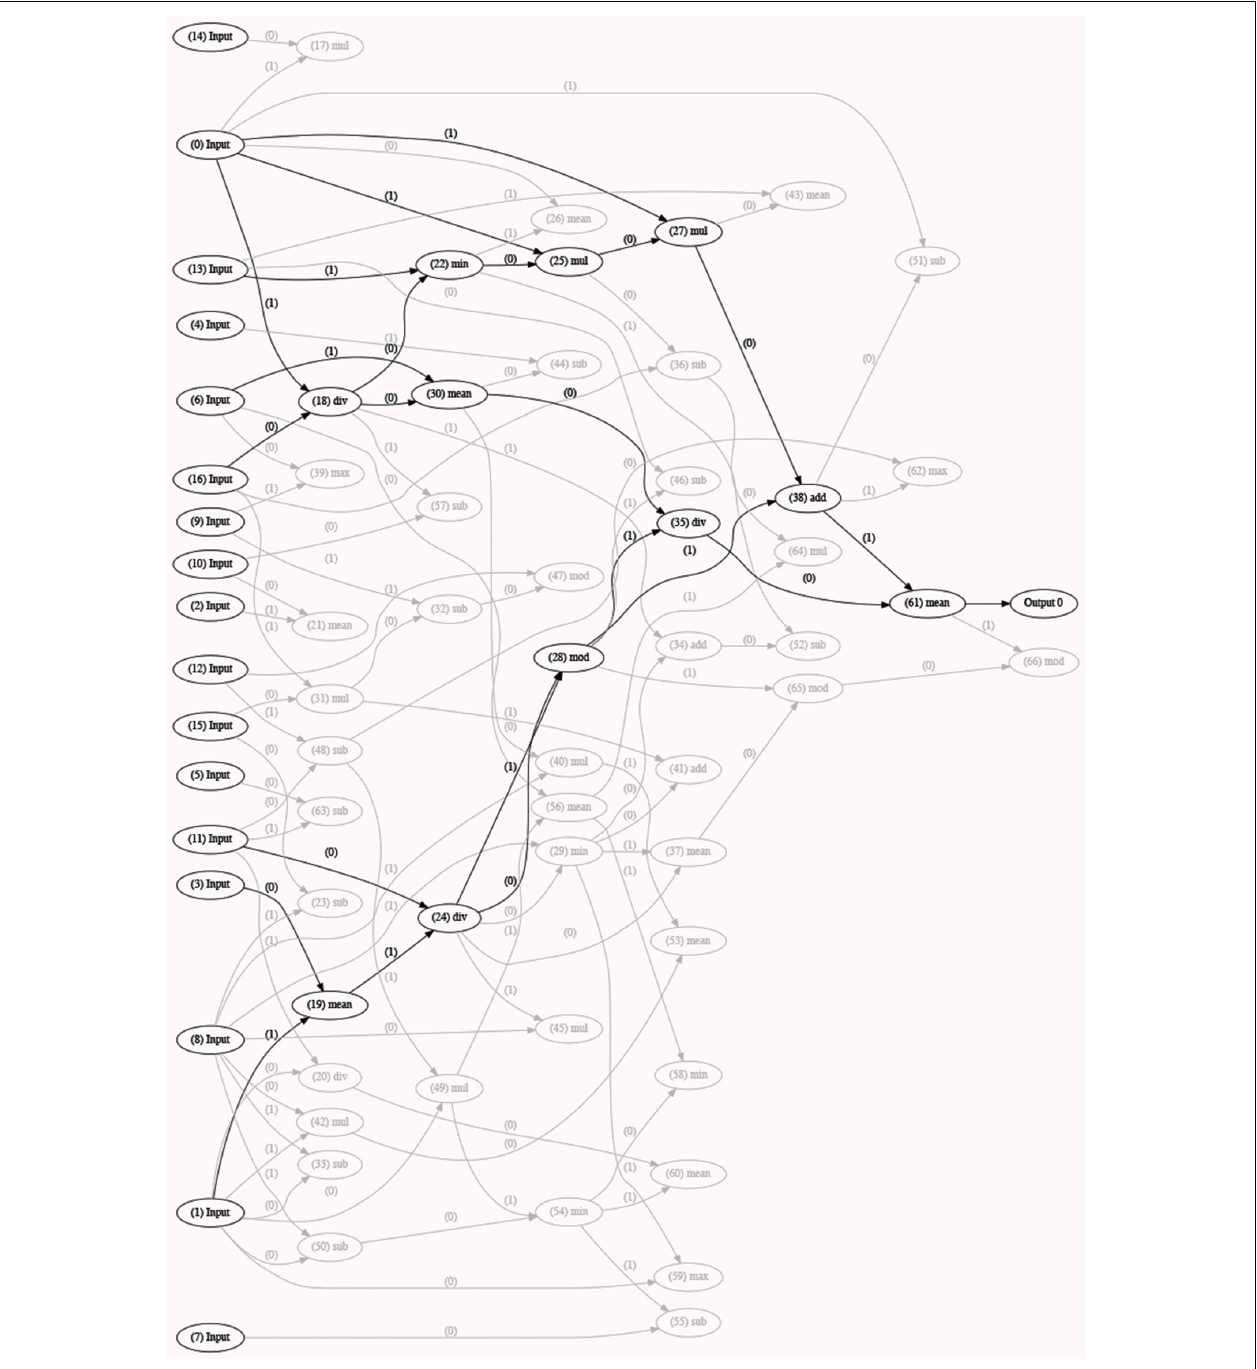
FIGURE 2 | Example of a generation of classification with the optimal model (best fitted chromosome) selected (in black). This model has used a certain number/set of inputs or speech features (inputs 0, 13, 6, 16, 11, 3, and 1) and a combination of different functions to form the best model (or fittest chromosome). Other models with lower accuracy rates are depicted in light gray in the figure. The selected model (or chromosome) is the fittest one of a certain run and is stored as an output, along with all the other runs, upon completion of 5 -fold cross-validation.